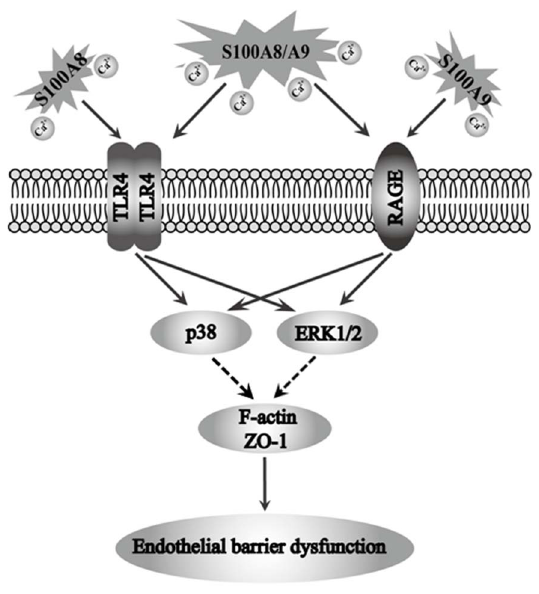
Figure 8. Schematic image of the signaling pathways of S100A8-, S100A9, and S100A8/A9-induced endothelial barrier dysfunction.